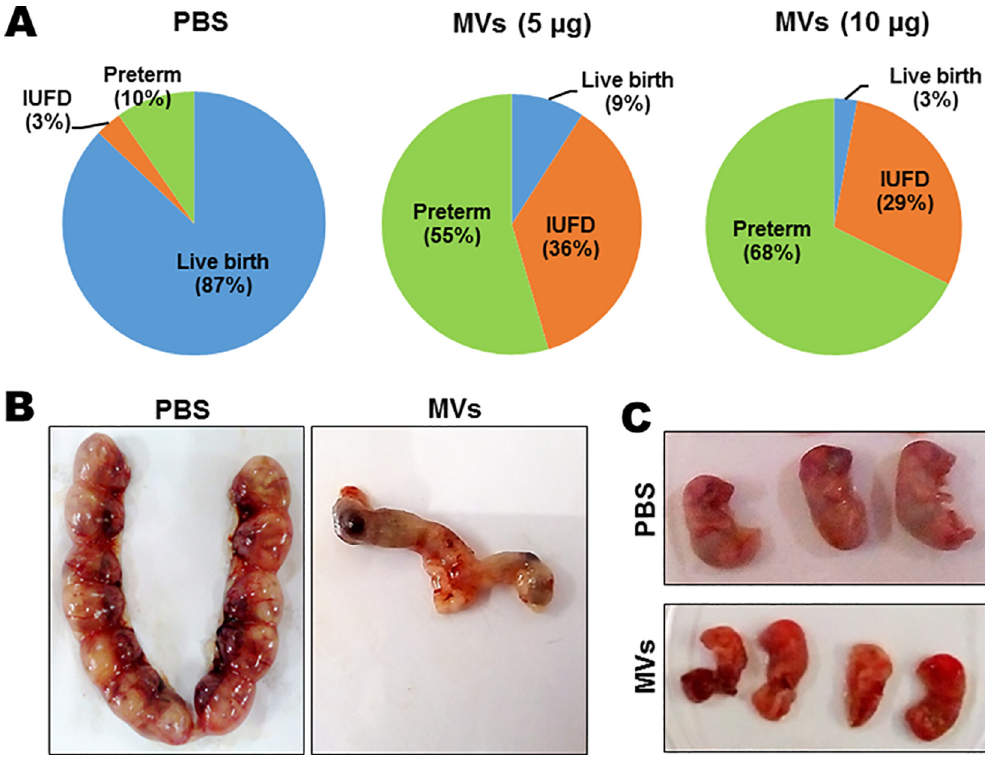
Fig 8. Intra-amniotic injections of GBS membrane vesicles lead to preterm birth and fetal demise. A. Fetal outcomes of intra amniotic injections with GBS membrane vesicles (MVs). Mice on E14.5 were injected with PBS or MVs (at 5 or 10 μ g of MV protein/sac) and observed for 72 h. The number of live births or pups delivered preterm (before E20) or intrauterine fetal death (IUFD) were recorded and represented as pie charts. B. Representative images of uteri of mice injected with MVs on E18.5 (72 h after injection). C. Representative images of pups on E18.5 derived from uteri or delivered after intrauterine injection of PBS or MVs on